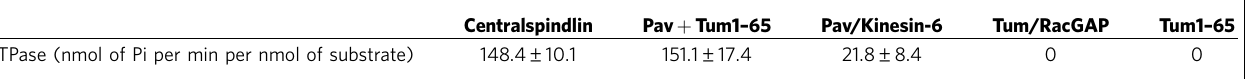
Table 4 | Comparison of ATPase activities between centralspindlin’s